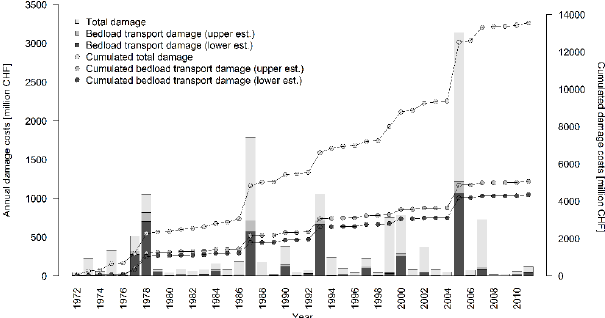
Fig. 2. Annual cost of damage caused by bedload transport pro- cesses in Switzerland from 1972 to 2011. While total bar length indicates the overall damage costs as recorded in the Swiss flood and landslide damage database (Hilker et al., 2009), the two darker grey tones give the lower and upper estimates for bedload transport damage costs. The different lines show cumulative costs for overall damage and damage due to bedload transport